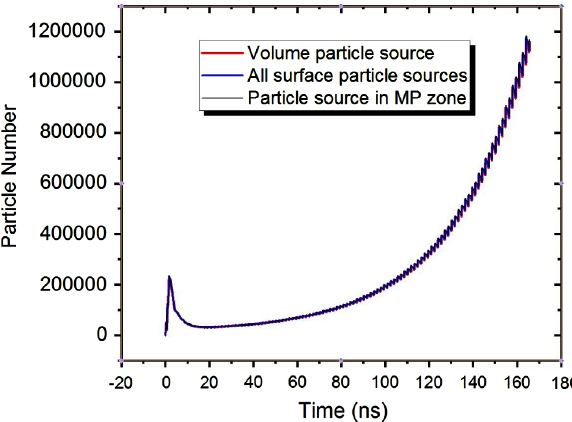
FIG. 29. Variation of the multipacting growth rate as a function of the number of the computational